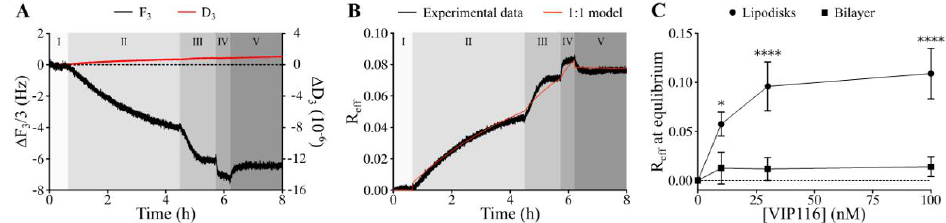
Figure 2. Results from the QCM-D experiments demonstrating the interaction of VIP116 with immobilized lipodisks. ( A ) Raw data displaying changes in the normalized frequency ( ∆ F / 3, black) and dissipation factor ( ∆ D, red) measured at the 3rd overtone. Di ff erent shades and roman numerals represent di ff erent stages: baseline (I), association phase upon the addition of 10 (II), 30 (III) and 100 (IV) nM VIP116 and dissociation phase (V) upon rinsing. ( B ) R e ff as a function of time as calculated from the QCM-D data (black) and fitted by a 1:1 binding model (red). ( C ) Binding isotherm of VIP116 to lipodisks (circles) and to a supported lipid bilayer (squares), (mean values, SD. N = 3). Solid lines are a guide to the